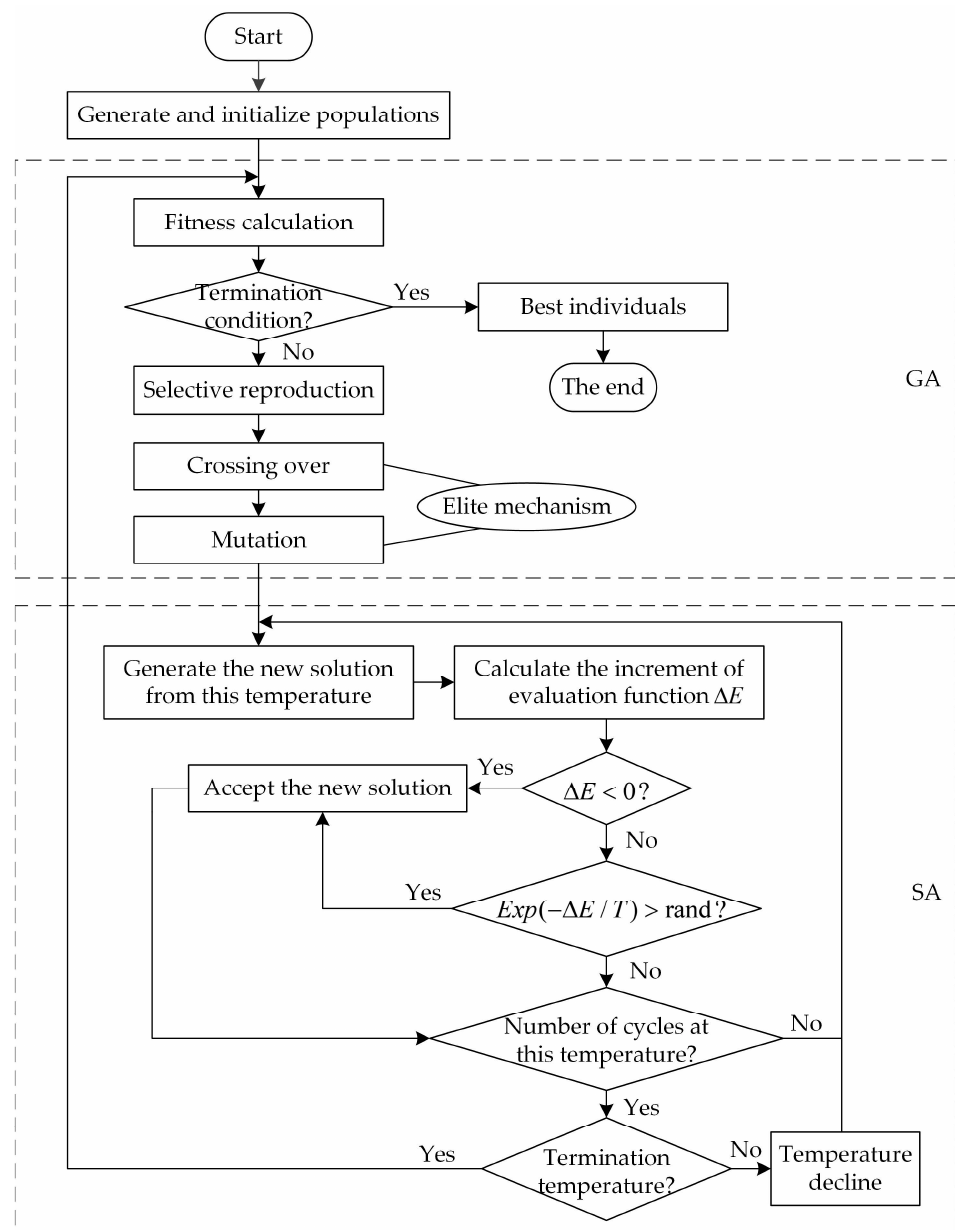
Figure 9. The flow chart of the HGSAA.